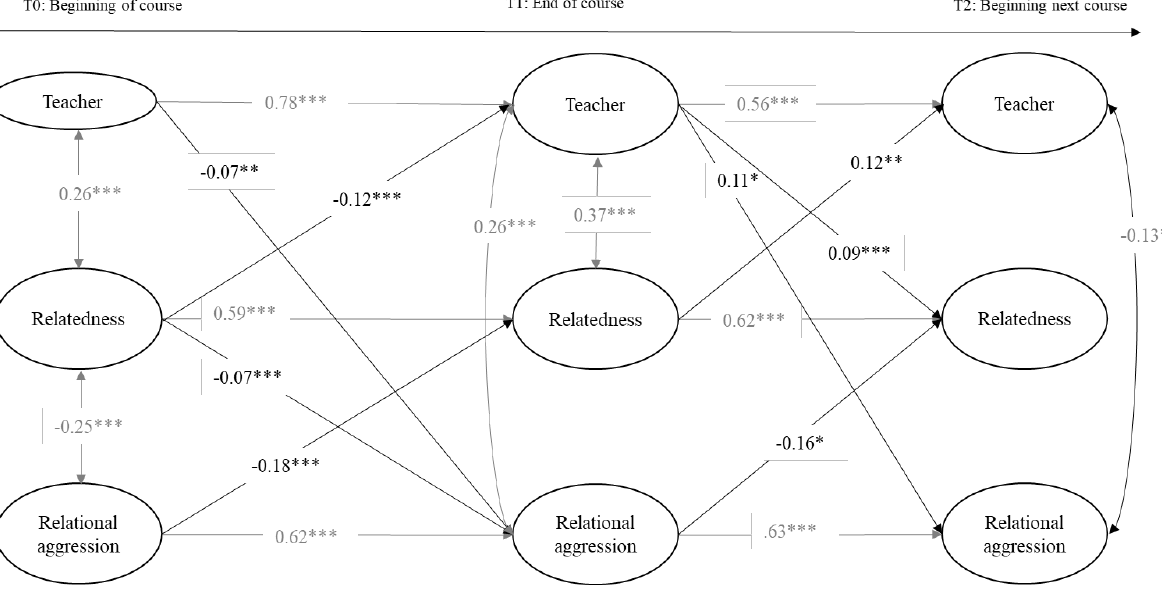
Figure 3. Cross-lagged model predicting longitudinal reciprocal relations between teacher support, relatedness, and rela- tional aggression in girls. Only estimates significant at p < 0.05 or less are provided. Cross-lagged paths are depicted in bold. * p < 0.05; *** p < 0.001.